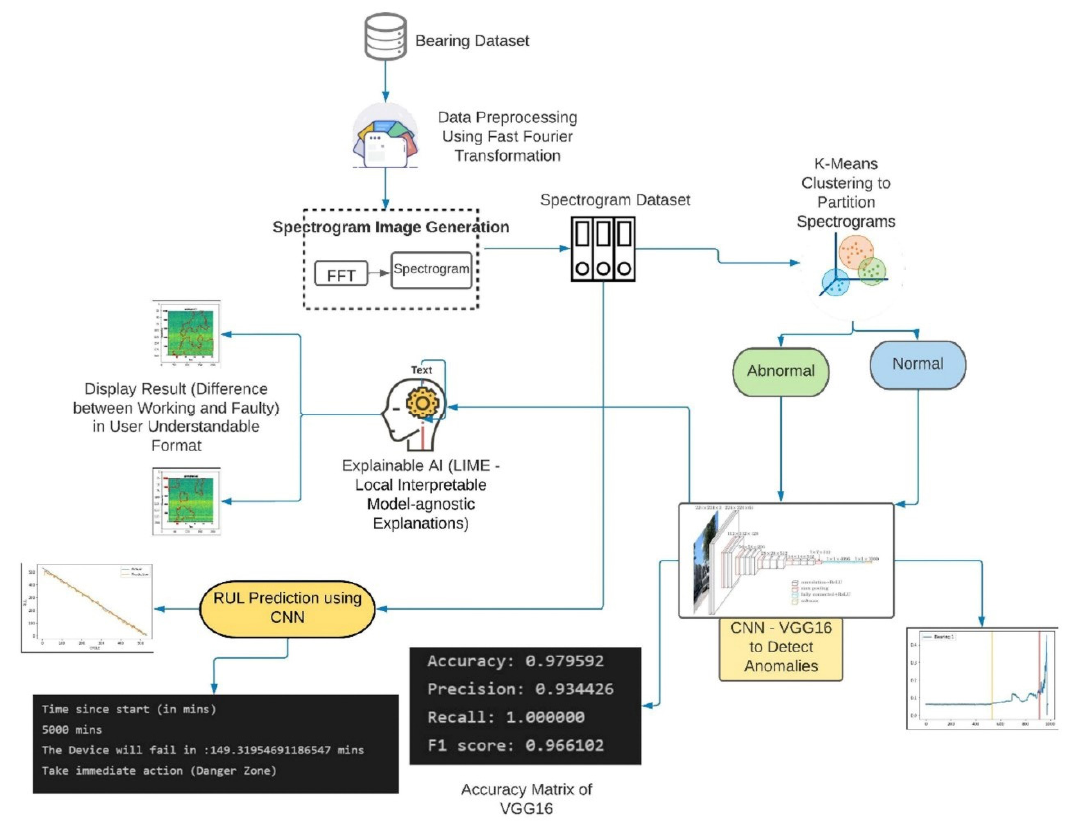
Figure 2. Proposed methodology diagram.